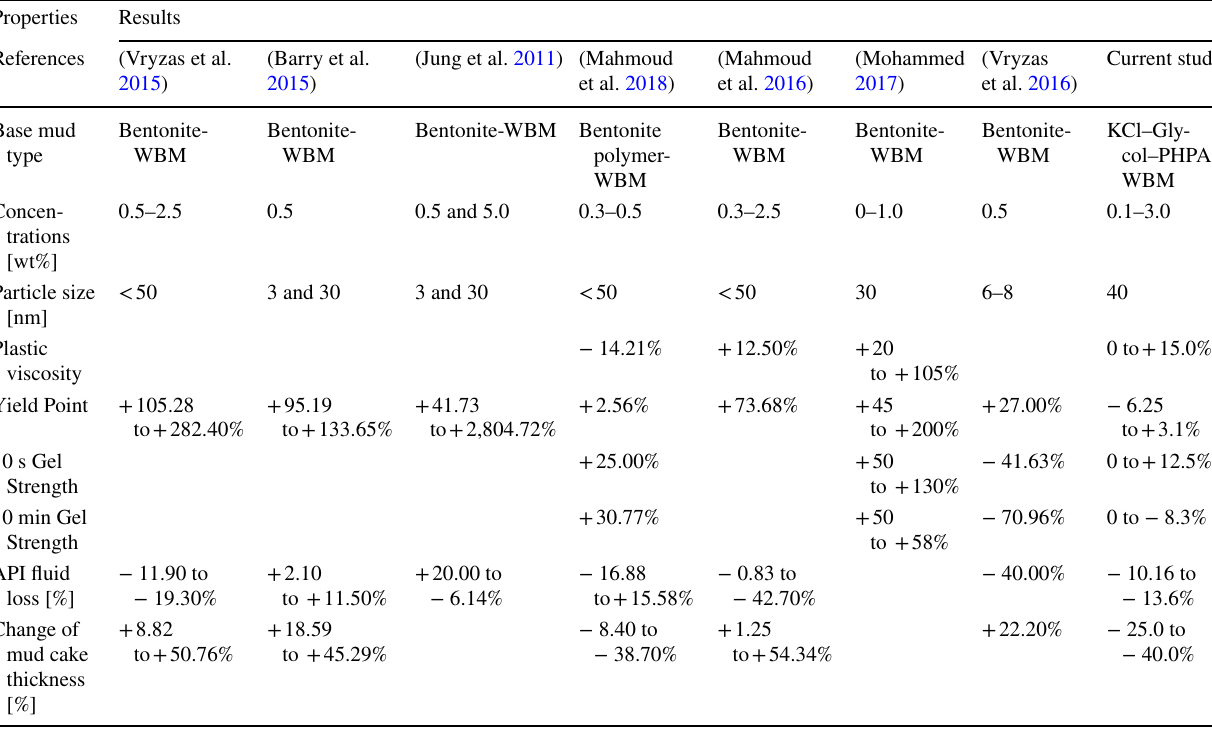
Table 1 Comparison between current study and previous works dealings with iron oxide nanoparticles